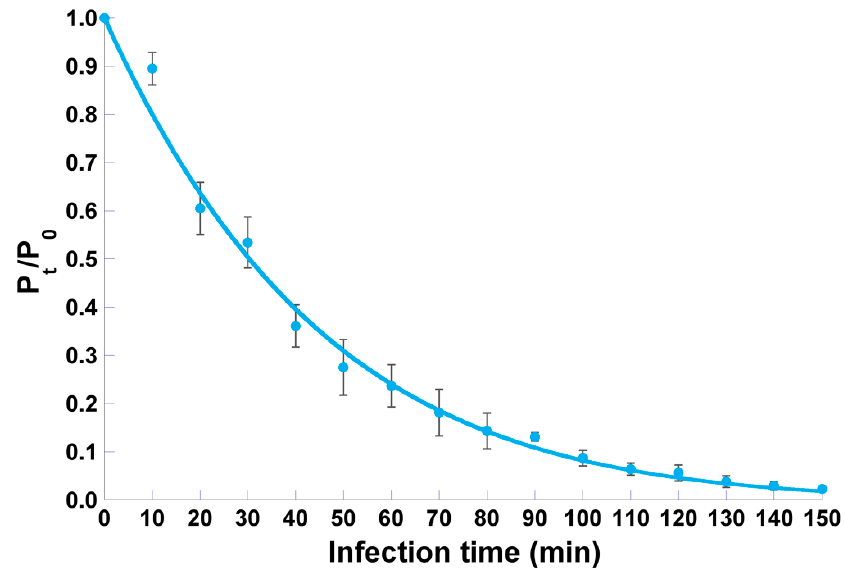
Figure 5. Adsorption curve of phage φ 6 particles onto P. syringae pv. syringae host cells, allowing calculation of the phage particles’ adsorption rate following non-linear fitting of a logarithmic function to the experimental data. Error bars represent the standard deviation